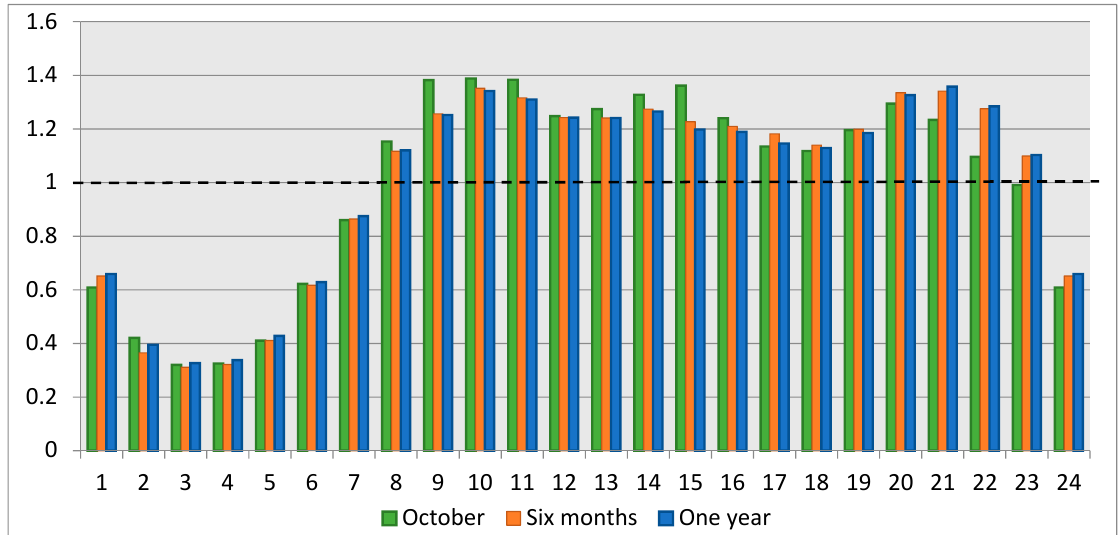
Figure 15. Simulation results for Scenario